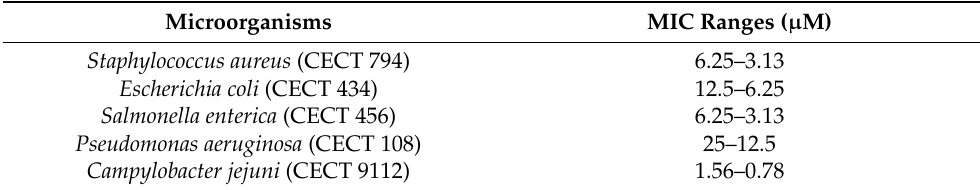
Table 6. Minimum inhibitory concentration ranges of the synthetic peptide To-KL37 against several